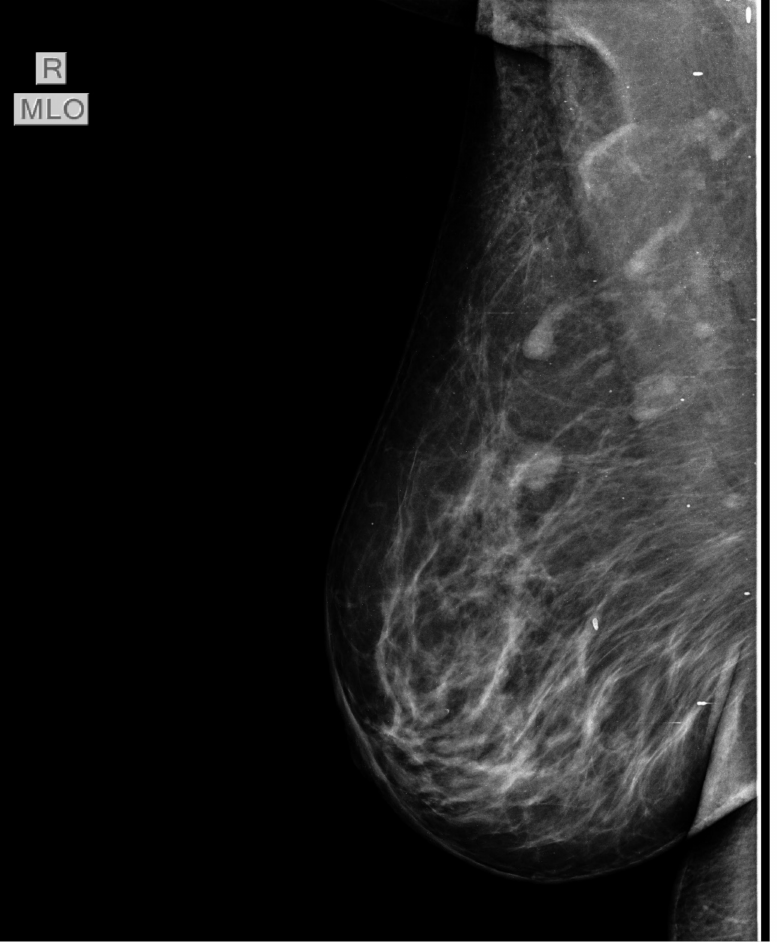
Figure 4. Mammography also revealed in the upper internal quadrant of the right breast, an oval shaped image, well circumscribed, with benign characteristics suggestive for a